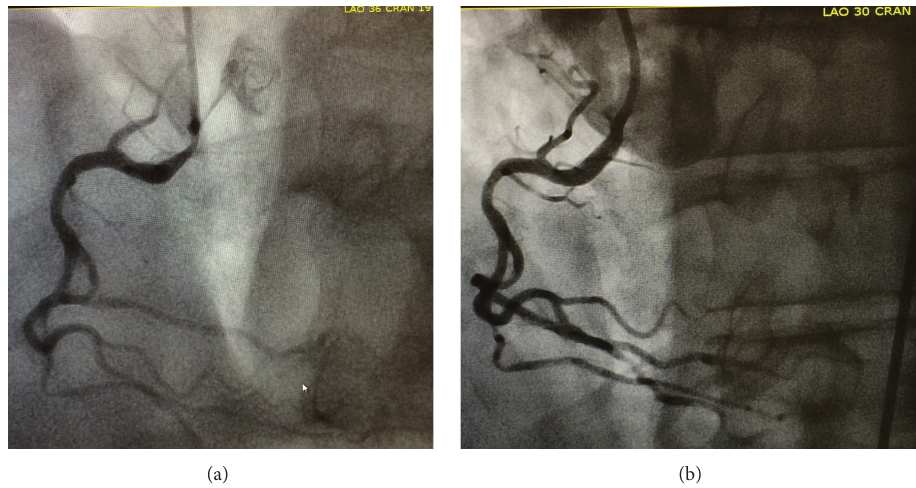
Figure 2: (a) Angiography revealed an 80% ostial stenosis in the right coronary artery; (b) right coronary artery after successful deployment of drug-eluting stent to ostial lesion.